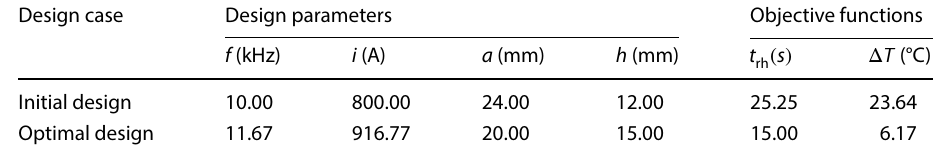
Table 7 Values of design parameters and corresponding objective functions for RTCM spoiler mold with initial and optimal design cases